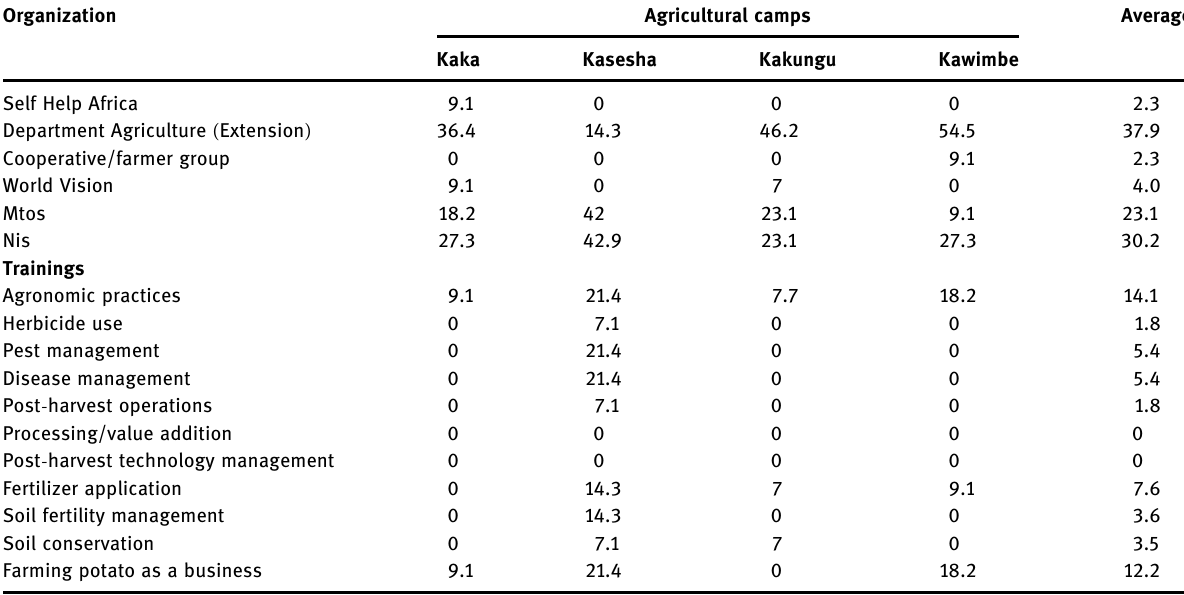
Table 5: Summary of farmer information sources in the cultivation of potato in Mbala district, Zambia, 2018 ( % of respondents )